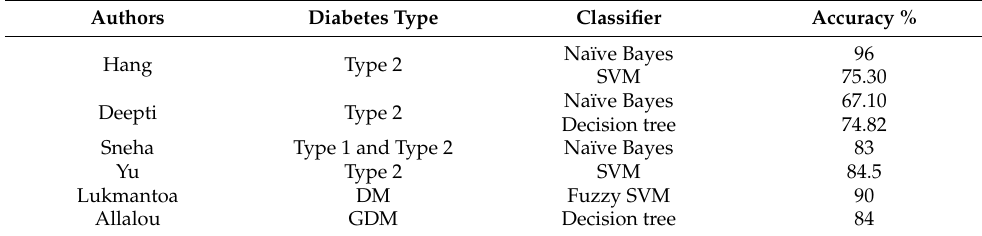
Table 3. Comparison of diagnosis and classification results by different